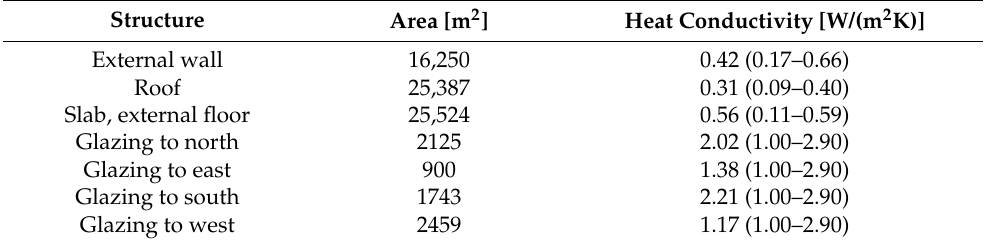
Table 1. Areas and heat conductivities of the building structures in the dynamic energy model. Heat conductivity is presented as the average value with the range of various structures in